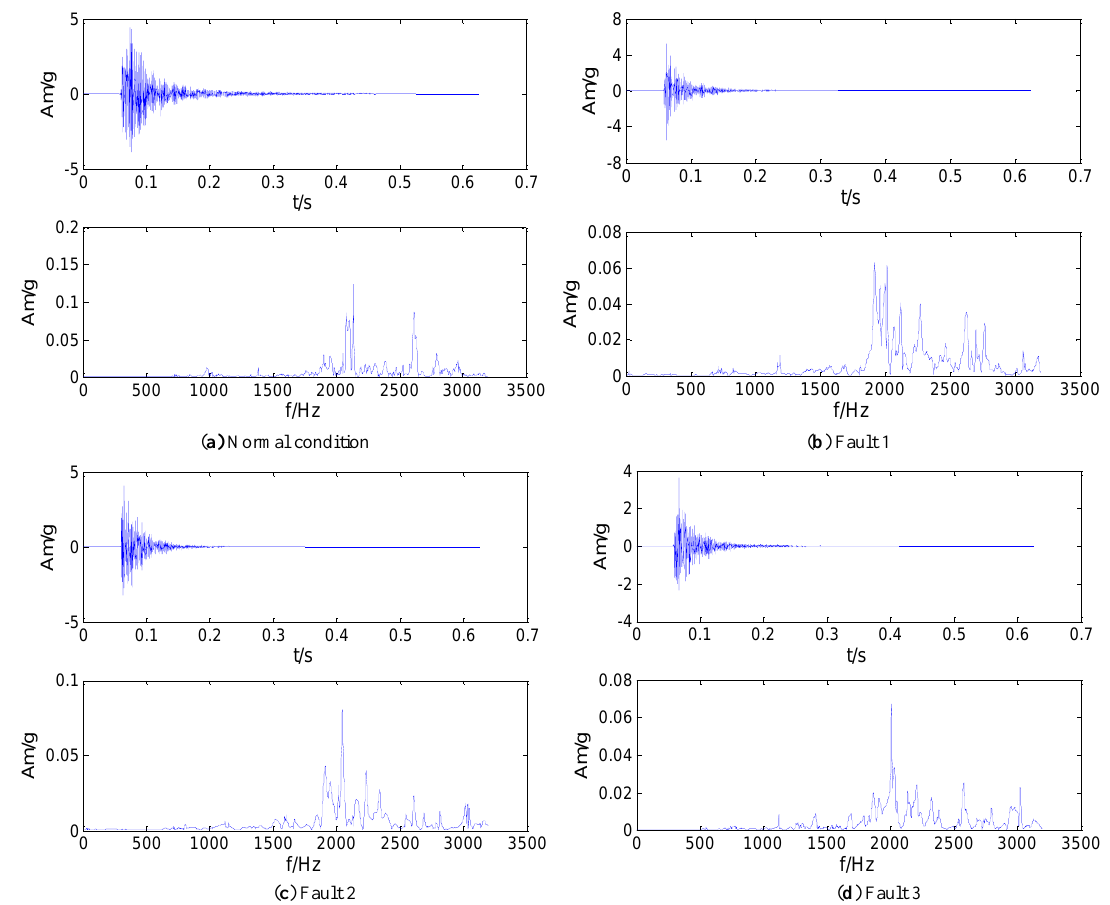
Figure 12. Vibration signals of time- and frequency